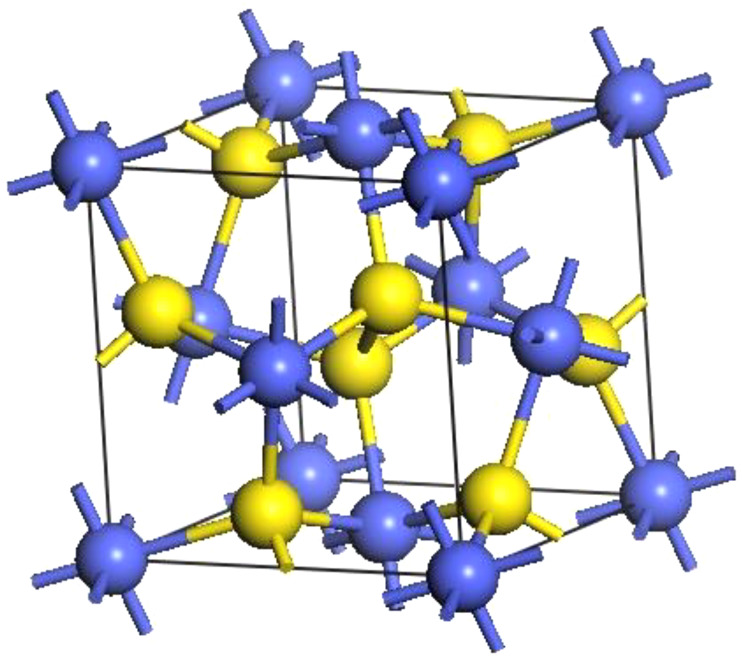
Bulk unit cell of CoS2. Blue spheres indicate Co atoms and yellow spheres indicate S atoms.